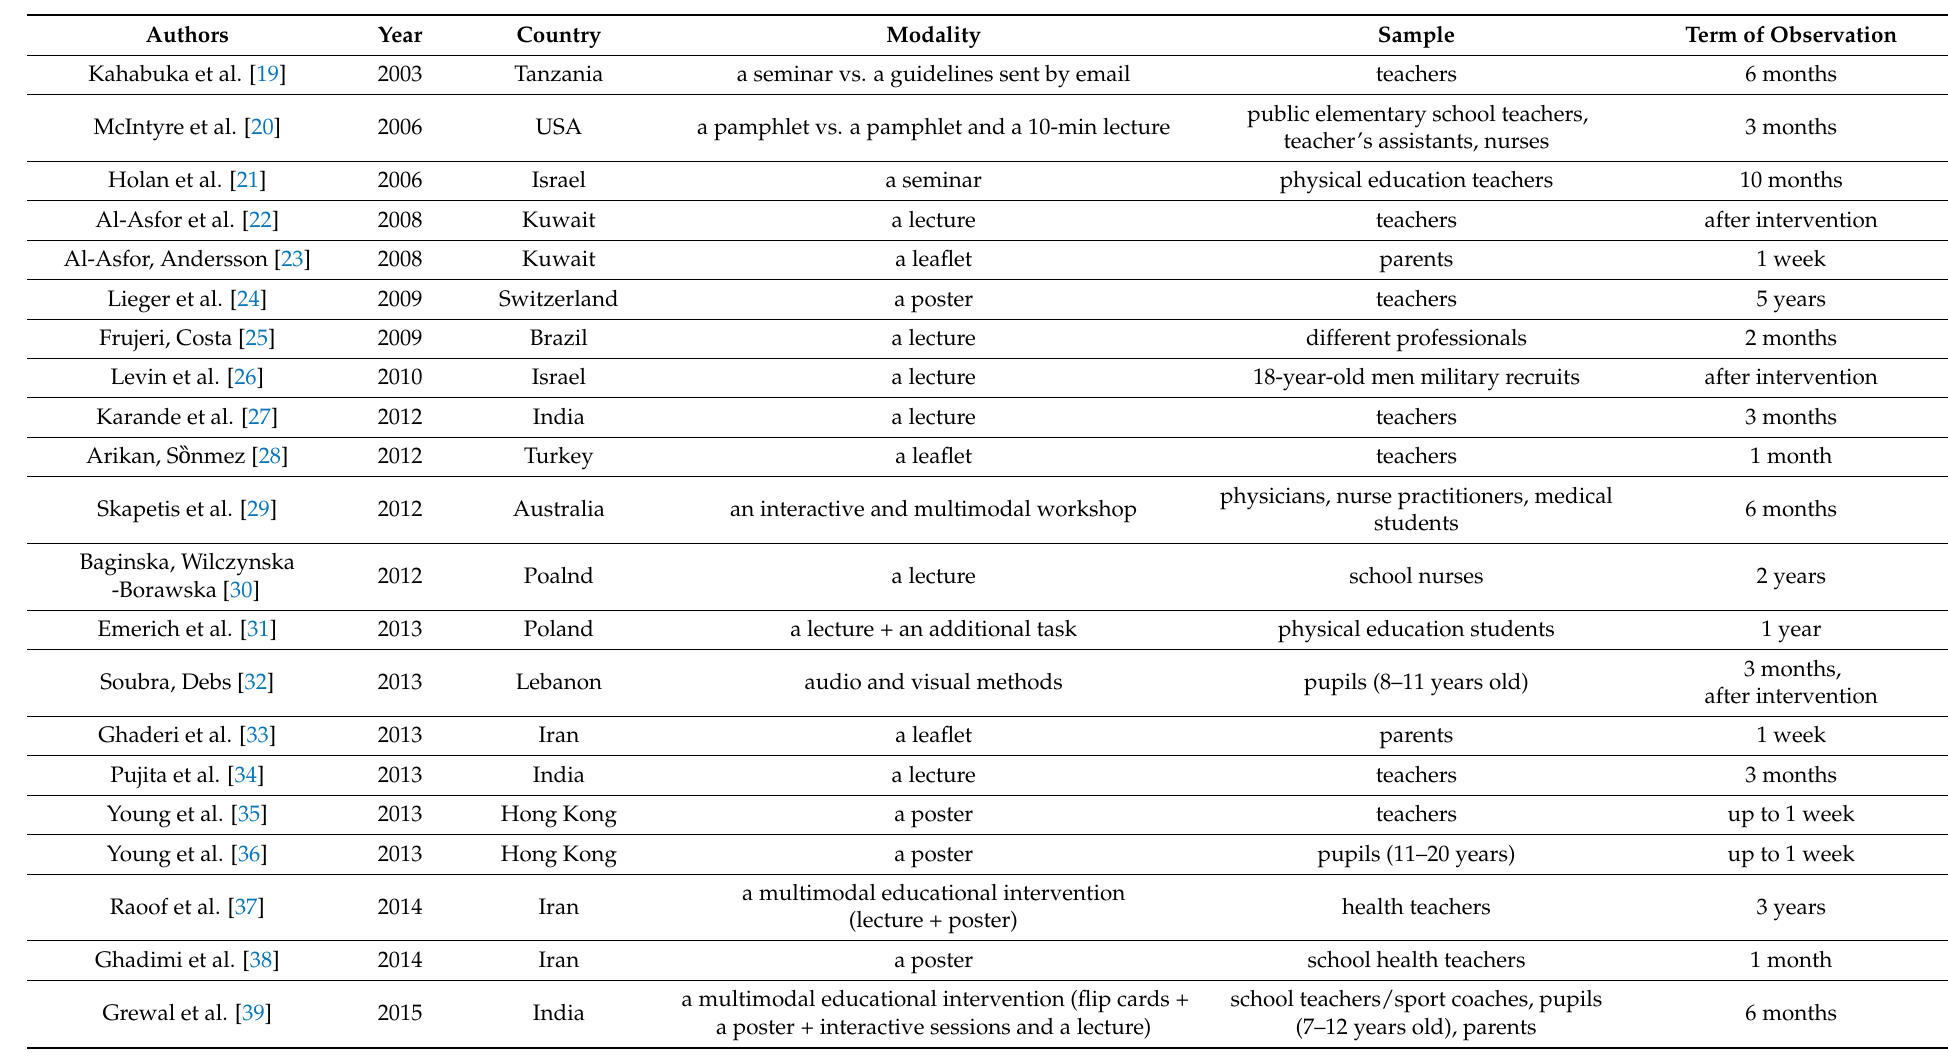
Table 1. Summary of studies focused on education in TDI.